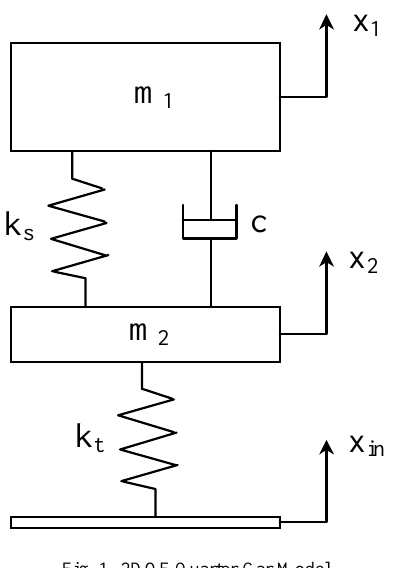
Fig. 1. 2DOF Quarter-Car